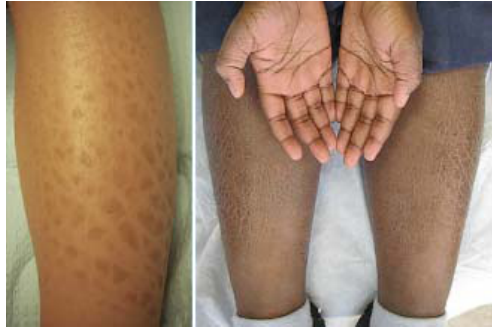
Figure 23. Ichthyosis vulgaris ( left ) and associated palmar hyperlinearity ( right